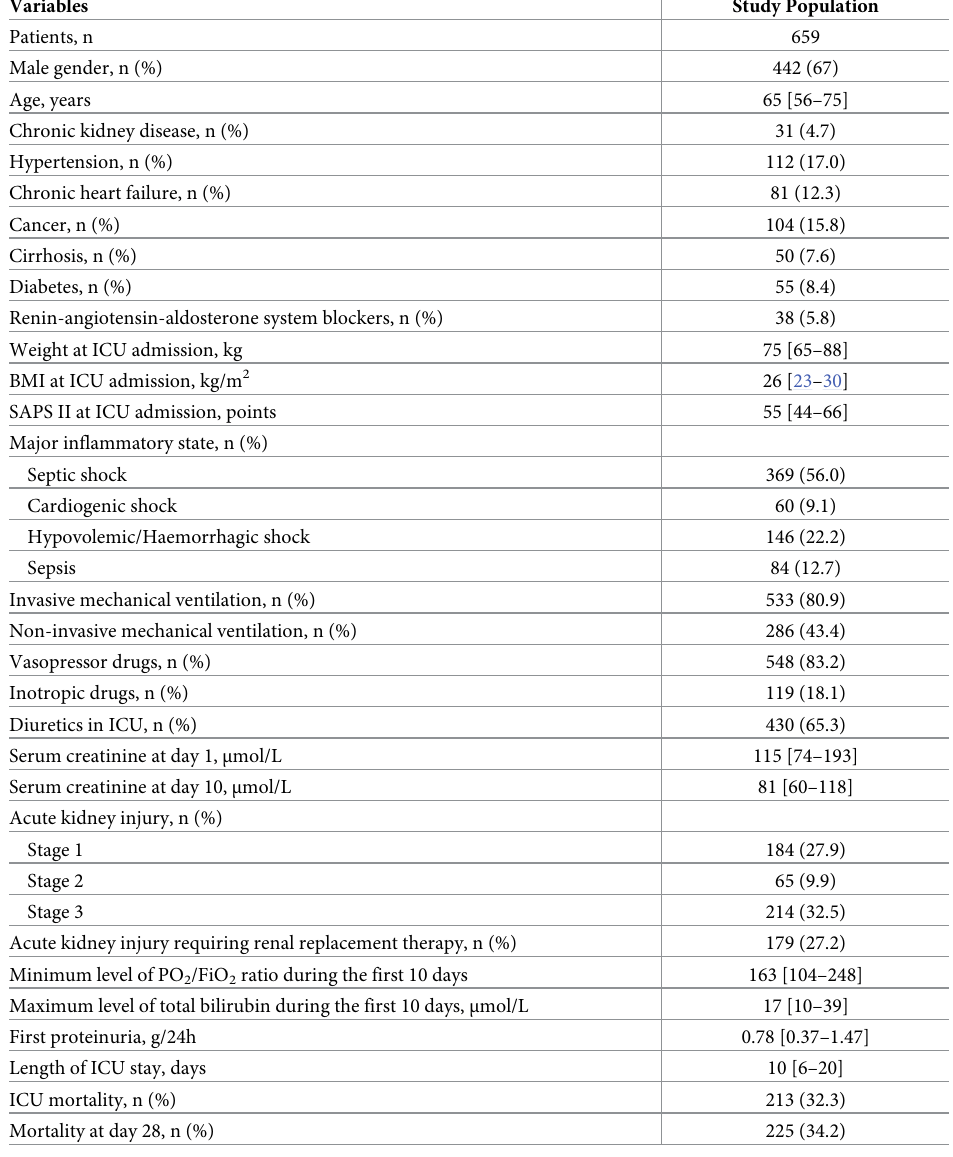
BMI: body mass index; SAPS II: simplified acute physiology score